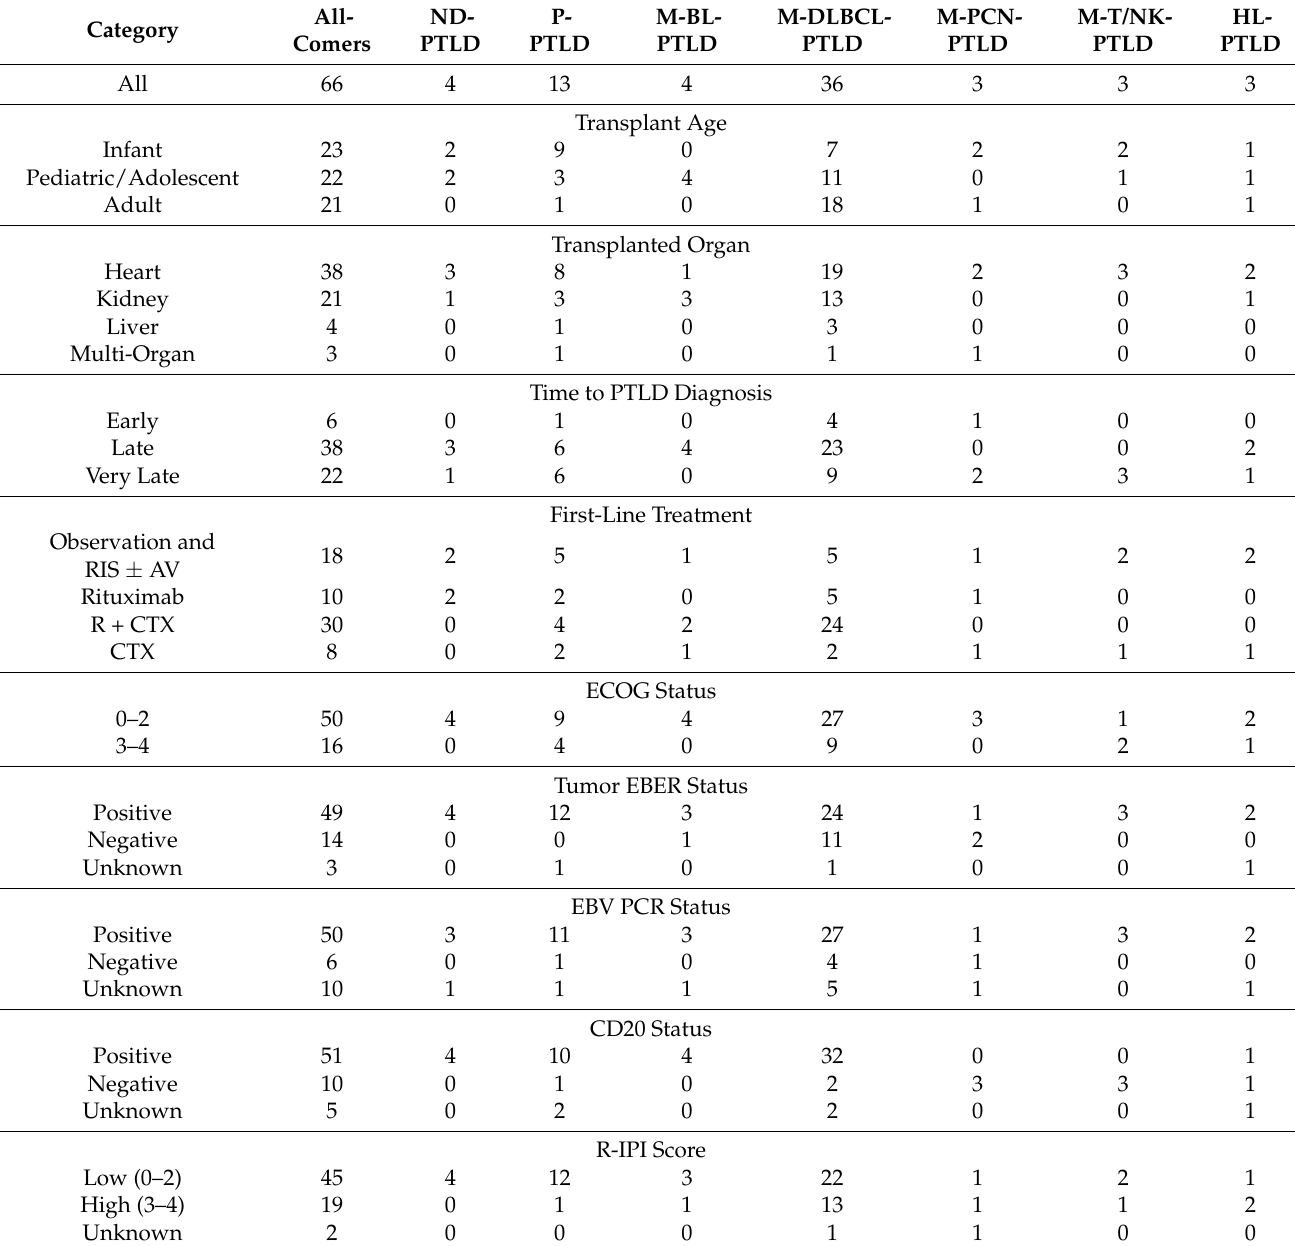
Table 2. Characteristics by histologic subtype of